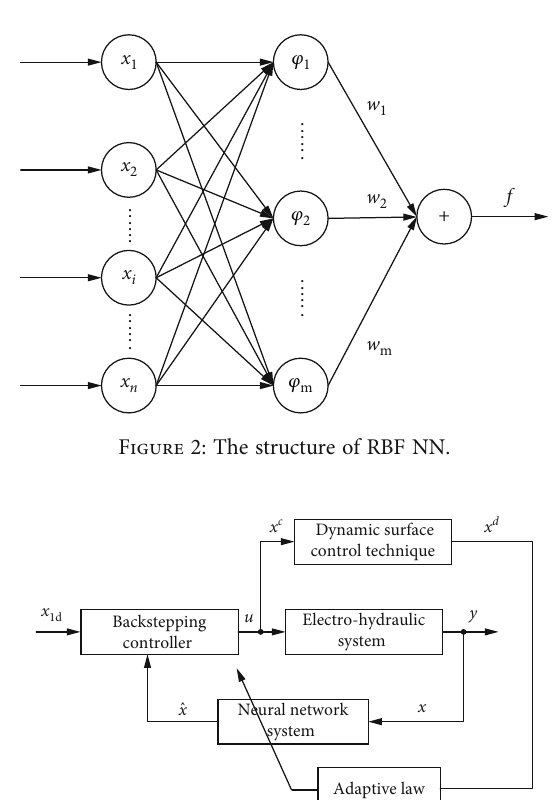
Figure 1: The schematic diagram of EHSS.